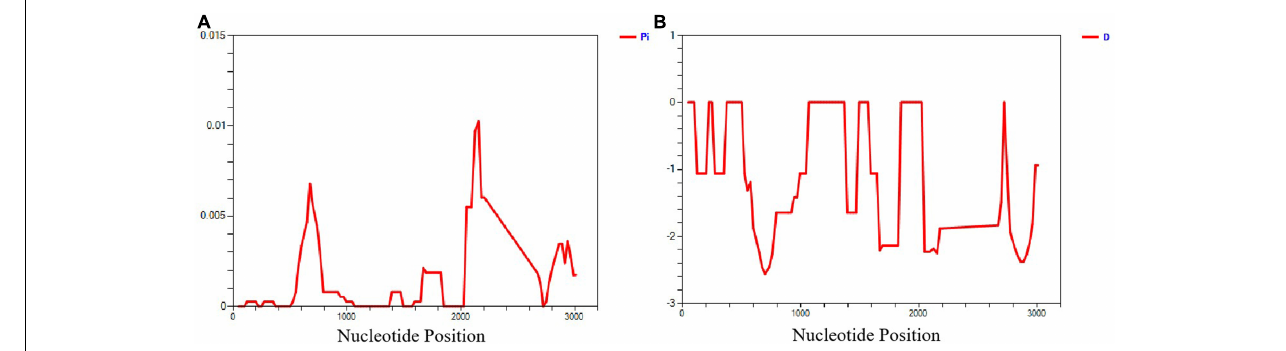
FIGURE 3 | Sliding window plot analyses show the sequence diversity ( π ) and Tajima’s D. (A) Sequence diversity of PfSRA. (B) Tajima’s D of PfSRA. TABLE 2 | Estimates of number of haplotypes, haplotype diversity, nucleotide diversity, and neutrality indices of pfsra. Region No. of